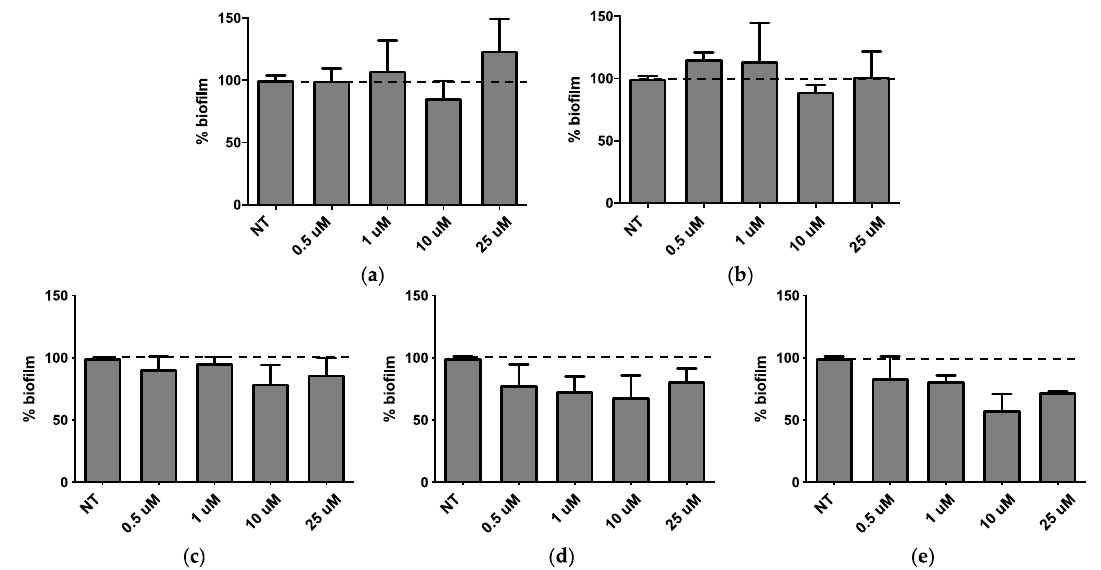
Figure 5. Activity of empty liposomes on biofilm after 24 h of treatment. ( a ) LP-P, ( b ) LP-DCP, ( c ) LP-DDAC, ( d ) LP-DEBDA and ( e ) LP-SA.